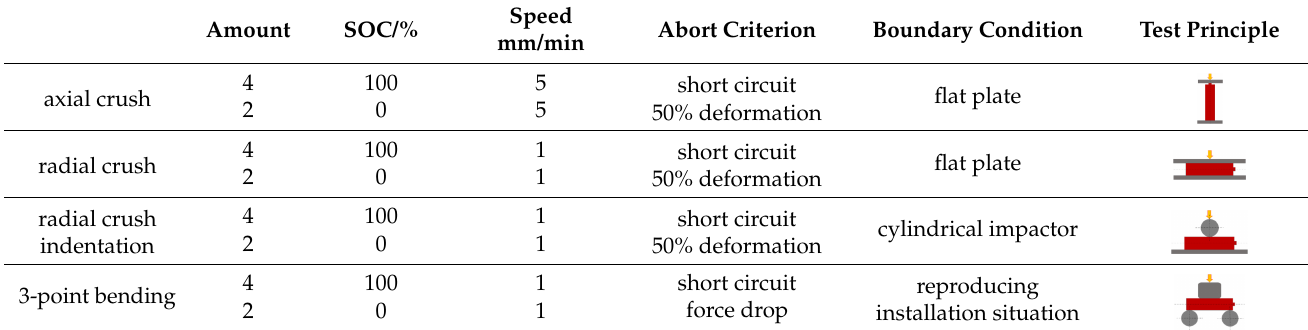
Figure 6. Radial crush impactor C1 (SOC comparison) force over displacement ( A ) and cell specimen after testing ( B ). 2.2. Cell Testing The tests of the whole cell (including the jelly roll) were conducted with four different test setups. Cells with maximal and minimal states of charge (SOC) were used. Table 2 shows the realized test matrix. Table 2. Four mechanical abuse tests for type 18650 lithium-ion battery cells.